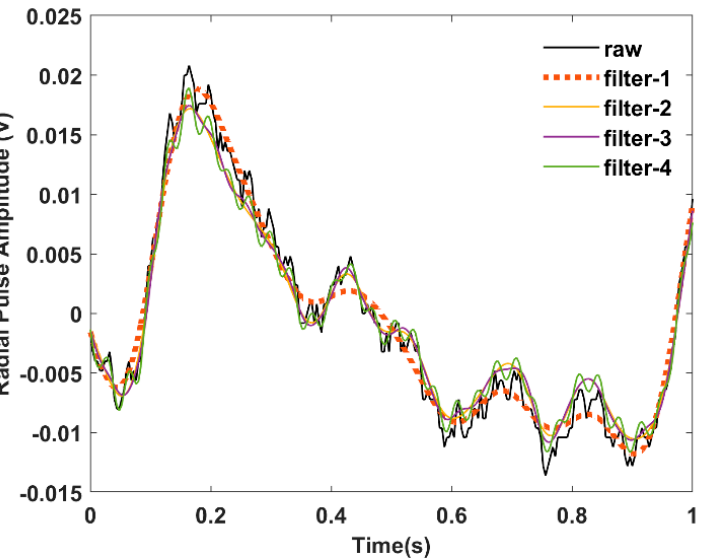
Figure 8. Effect of different low ‐ pass cut ‐ off frequencies on radial pulse waveform.